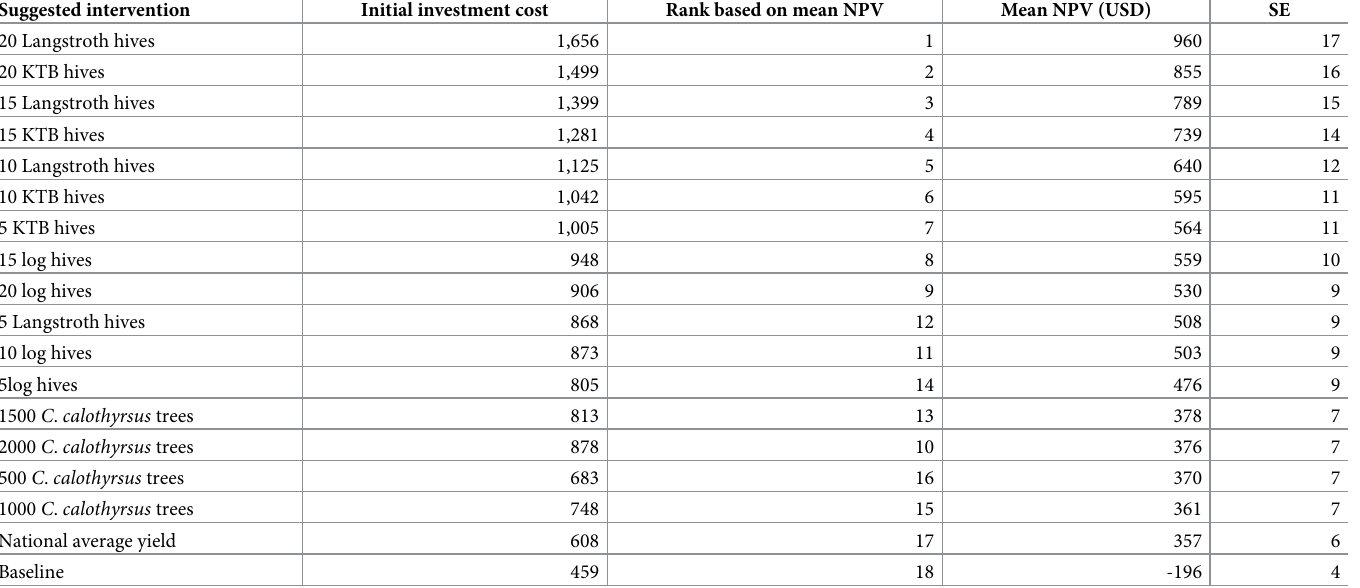
Table 6. Ranking of the interventions based on NPV � . Suggested